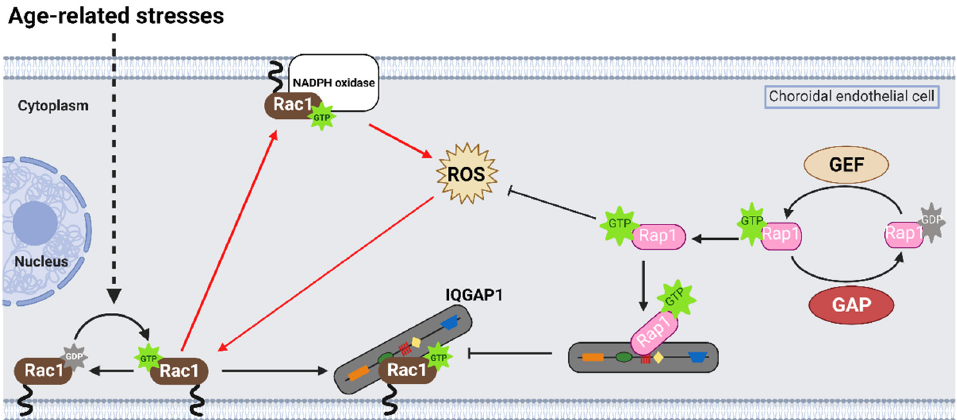
Figure 3. Active Rap1 antagonizes Rac1 activation by age- and AMD-related stresses in choroidal endothelial cells. Rap1 is a Ras-like small GTPase that cycles from an active, GTP-bound, state to an inactive, GDP-bound, state in choroidal endothelial cells. Active Rap1 (Rap1GTP) antagonizes Rac1 activation by age-related stresses, such as vascular endothelial growth factor (VEGF) or tumor necrosis factor alpha (TNF α ). Active Rap1 binds to the IQ domain of IQGAP1 (red domain) and interferes with active Rac1 binding the GRD of IQGAP1 (dark green domain). Active Rap1 also interferes with reactive oxygen species (ROS) generation that further activates Rac1 by feed-forward signaling (red arrows). Dashed lines represent indirect interactions, and solid lines represent direct interactions (image created with BioRender.com).